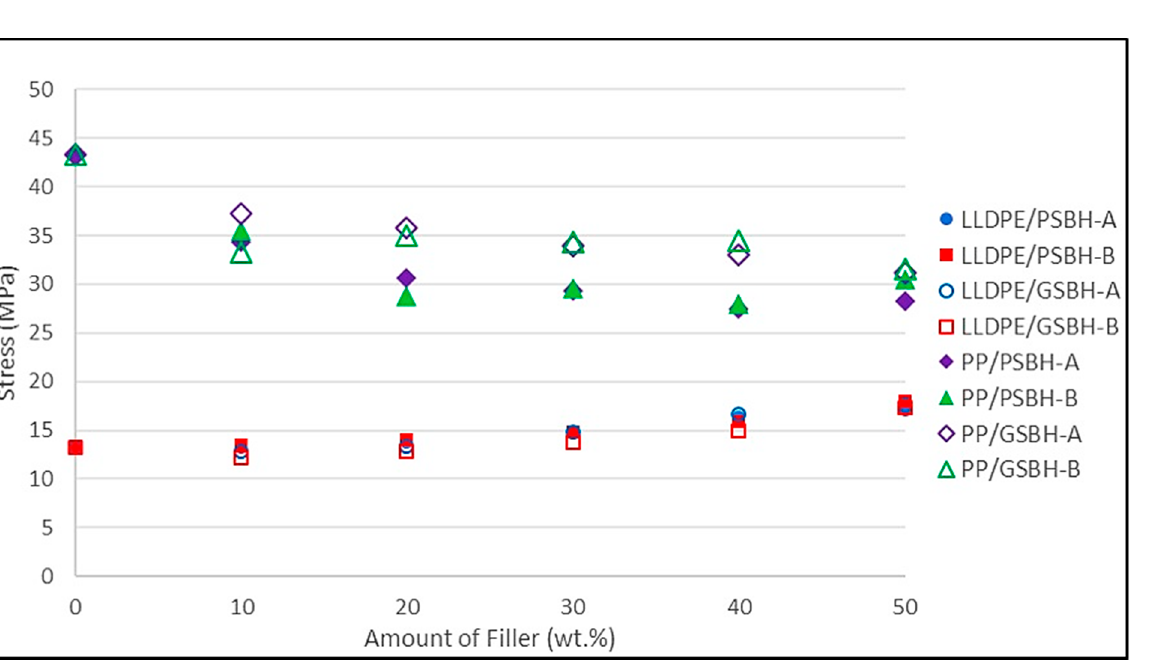
Figure 6. Maximum tensile stress of all composites at all weight percentages.